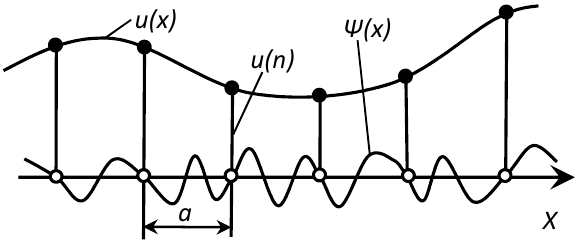
Figure 19. The one-dimensional quasicontinuum.